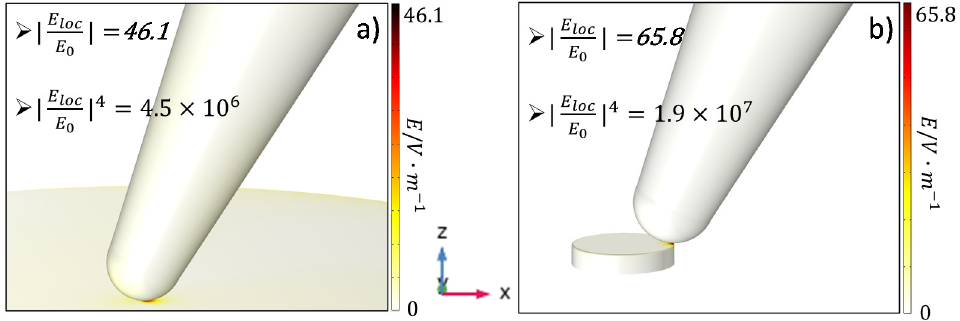
Figure 6. 3D simulation results of ( a ) Au tip with diameter of 80 nm on the flat gold substrate; ( b ) Au tip with diameter of 80 nm at the edge of a 20 nm high Au nanodisc with disc diameter of 100 nm. The electric field EF and corresponding TERS EF are presented in the figures respectively.